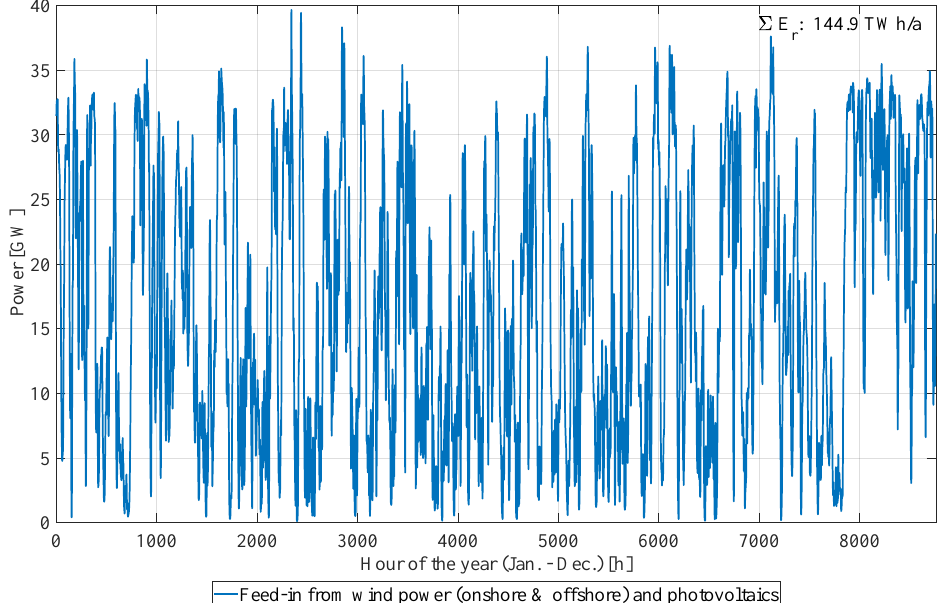
Figure 3. Annual course of the electrical feed-in profile of renewable energies (offshore and onshore wind power as well as photovoltaic) for Lower Saxony according to the expansion targets planned for 2050 and the Climate Protection Scenario 80. Source: Own representation based on raw data from